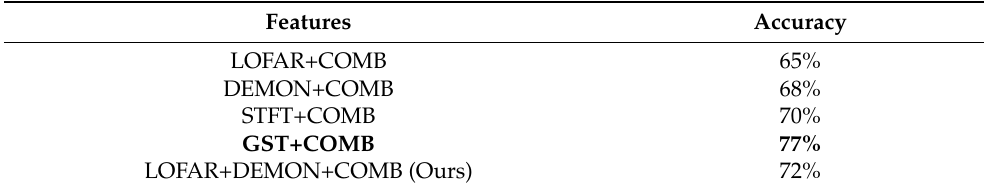
Table 5. Performance of each feature when feeding into CRNN for object counting on the simulation dataset (COMB included).